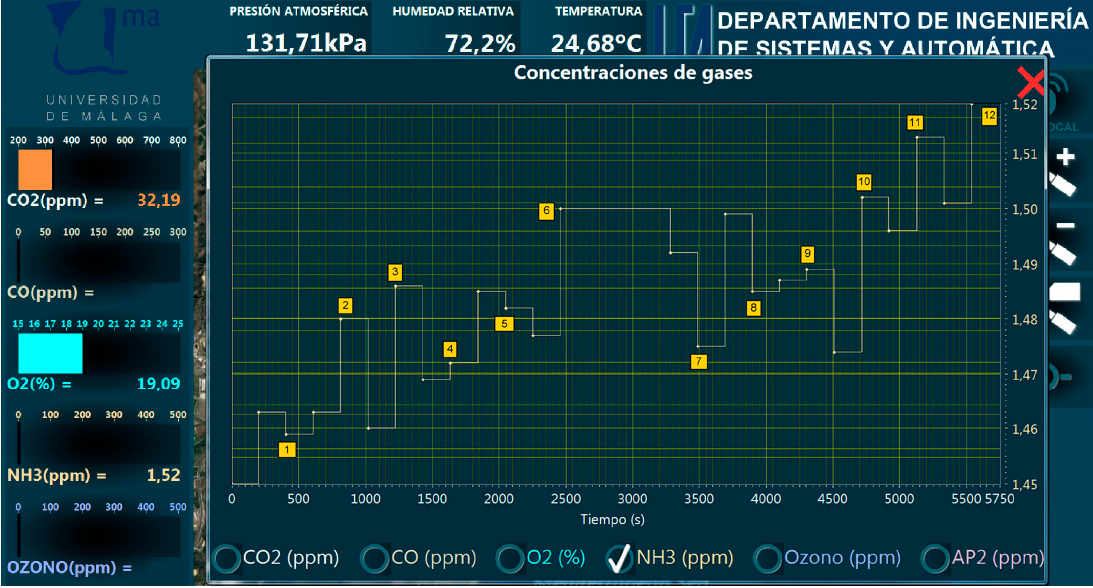
Figure 14. Measurements for the NH3 sensor obtained in a networked mode experiment, as shown by the user interface.